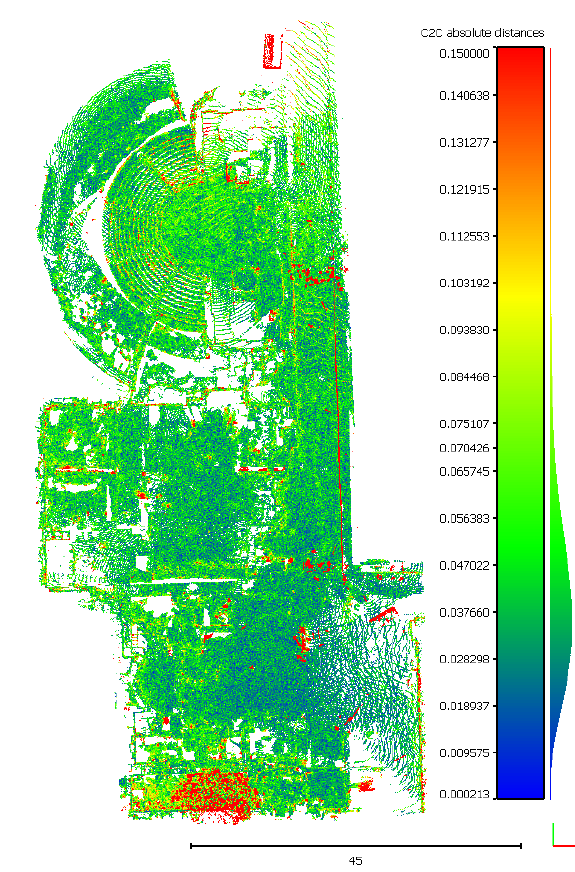
Figure 5. The Odeon and the Asclepion on the Nea Paphos Site. Distances between point clouds from Terrestrial Laser Scanner and dense matching of aerial